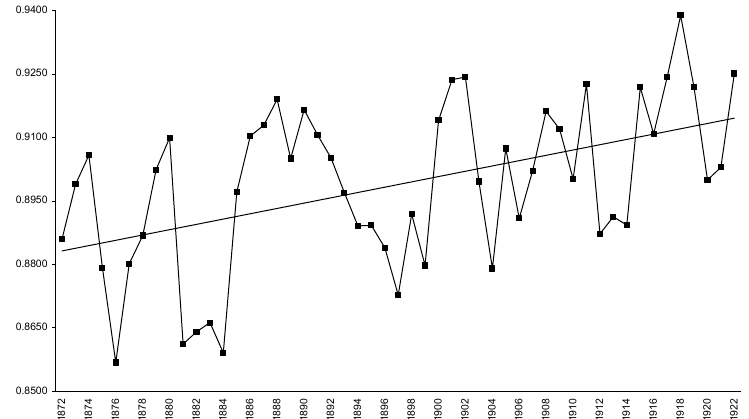
Figure 2 – Probability of dying (both sexes) between 80 and 90 years of age in Italy from 1872 to 1922, according to HMD period life